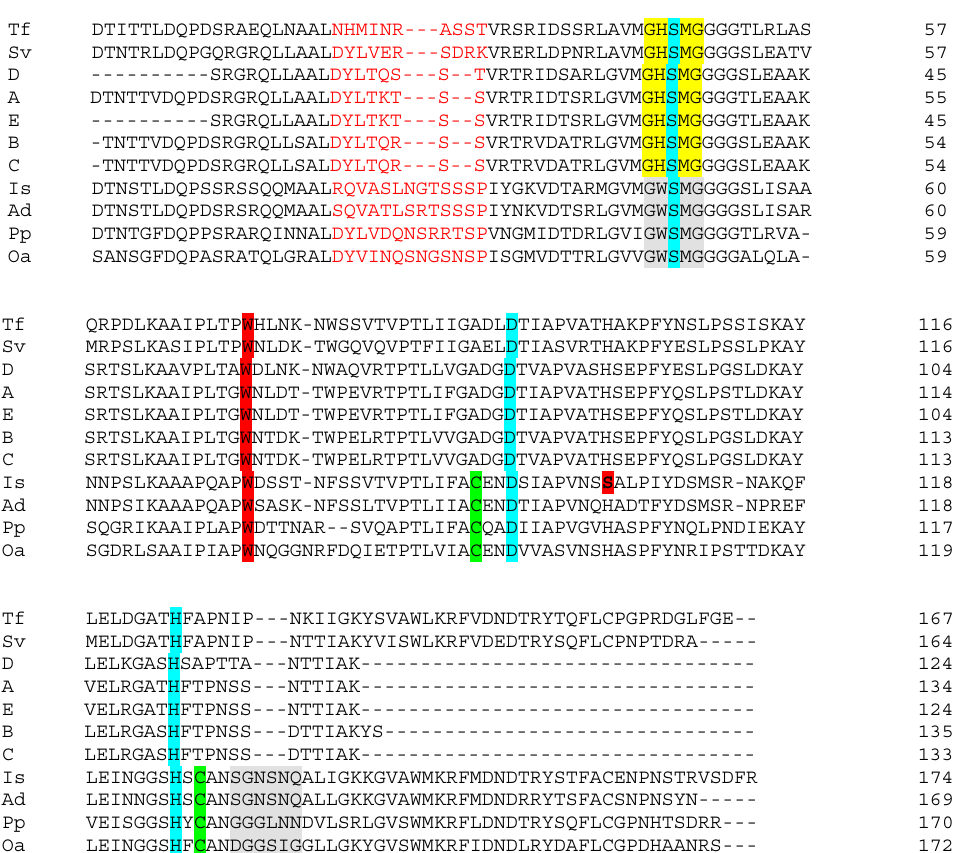
Figure 2. Alignment of putative PET-degrading enzymes. Is, Ad, Pp, Oa, Tf and Sv are representations of the enzymes from Ideonella sakaiensis (PETase), Acidovorax delafieldii, Pseudomonas pseudoalcaligenes, Oleispira antarctica, Thermobifida fusca and Saccharomonospora viridis , respectively (see [14] and references therein). A, B and C are enzymes from Streptomyces isolates iv, viii and xi (Table 2 in the present work). Sequences C and D are from Streptomyces spp. isolated in a separate study of PCL-degrading bacteria. Color code: Residues marked in light red form a region close to the catalytic site, which is shorter in the Streptomyces enzymes than in PETase. The residues marked yellow/grey form the motif G-X1-S-X2-G, which is highly conserved in serine hydrolases. Residues S,D,H highlighted in turquoise are the canonical catalytic triad of cutinases. Cysteine (C) residues, representing a potential for disulfide bond formation, are marked in pale green. The extended loop is highlighted in grey. W marked in dark red is present in all sequences and is probably involved in binding of substrate. However, the serine, S, also marked in dark red, is found exclusively in PETase. Serine at this position allows rotation of W (‘wobble’), which has been shown to be important for effective substrate binding by the I. sakaiensis